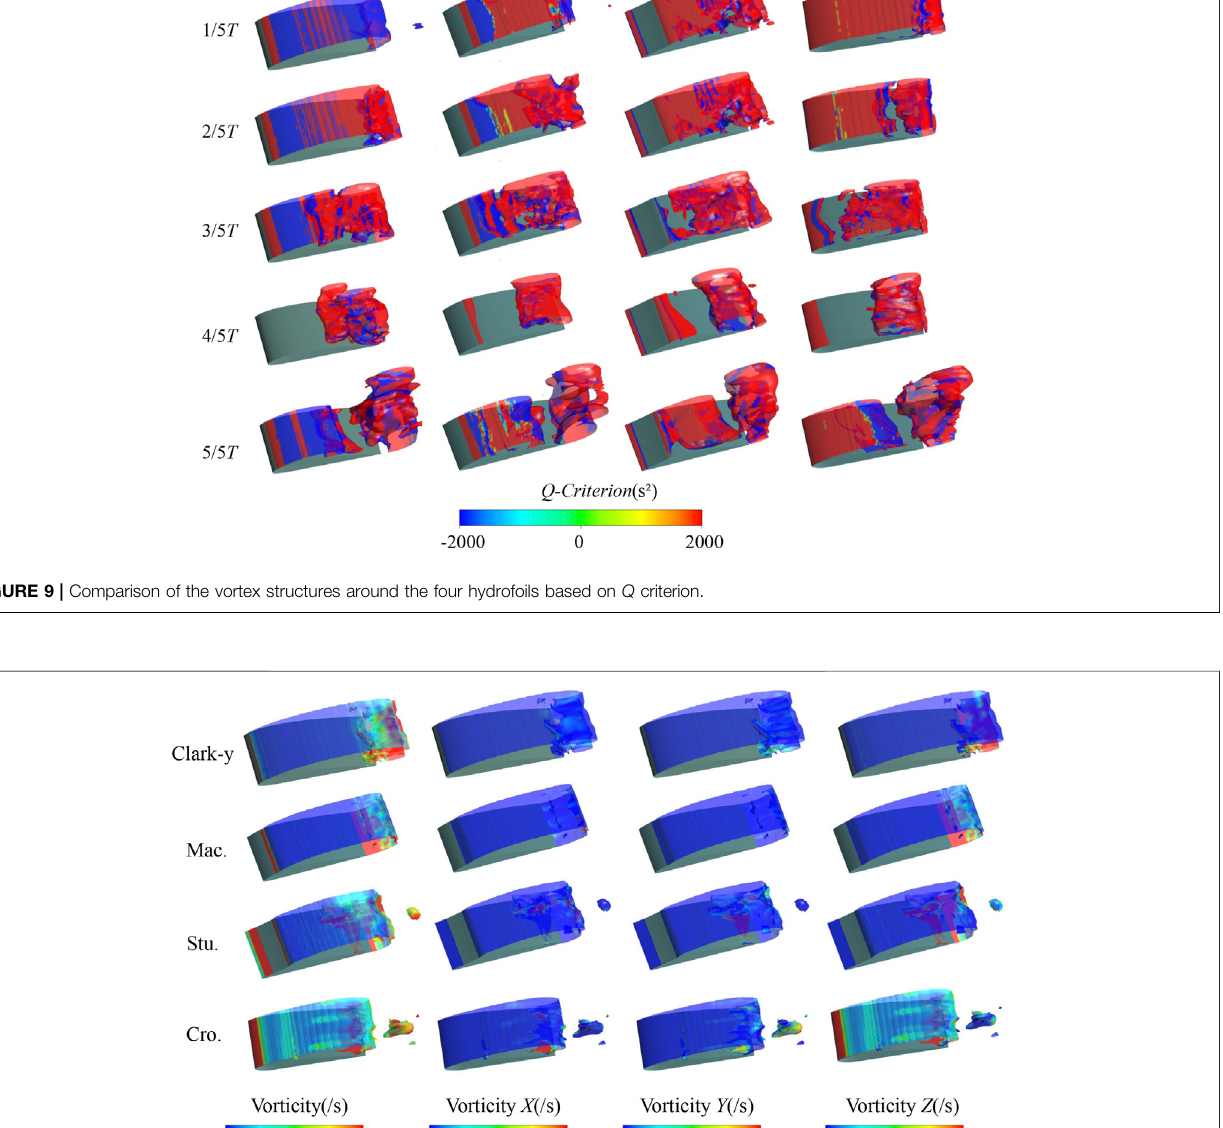
Frontiers in Energy Research |